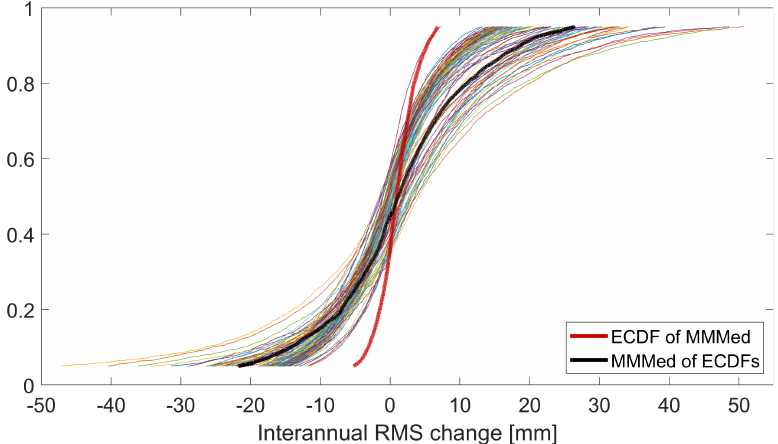
Figure 3. Example for different range of values for the ensemble members and the